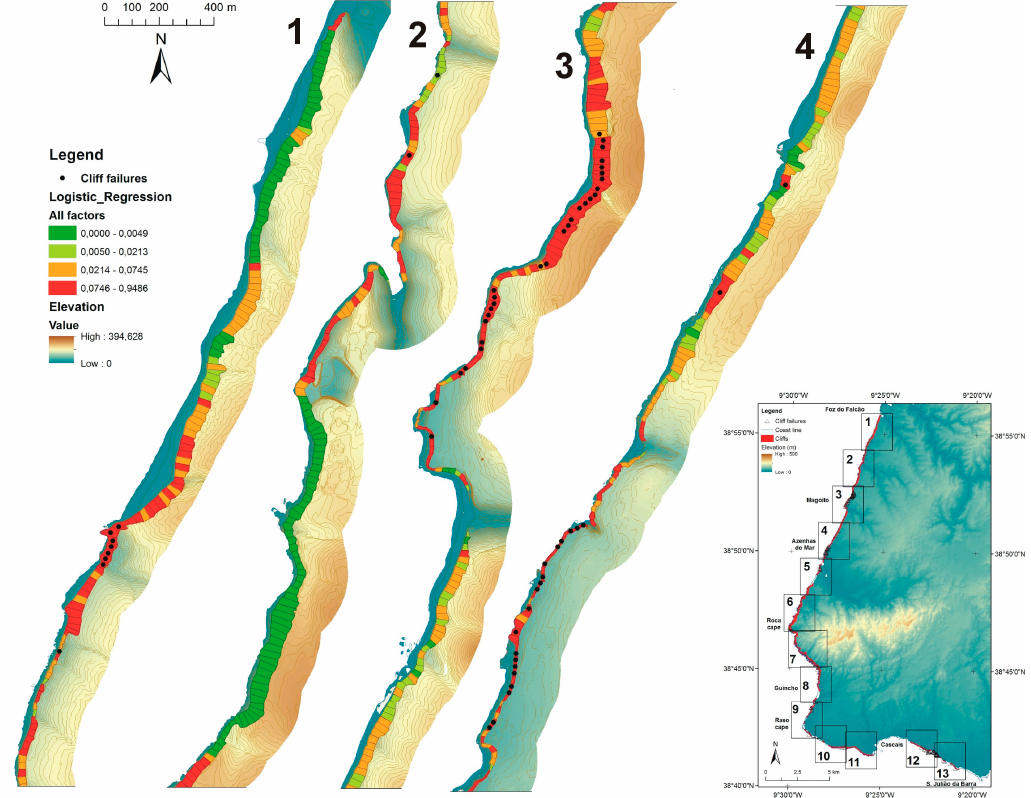
Figure 6. Susceptibility mapping (1/4) based on the logistic regression model with all factors, with indication (dot) of the terrain units with cliff failures, for cliff sections 1 to 4, with general legend and localization map with numbered boxes indicating the extent of the cliff sections. Classification of logistic regression probability values in quantile-based classes. Contour line interval is 2 m.